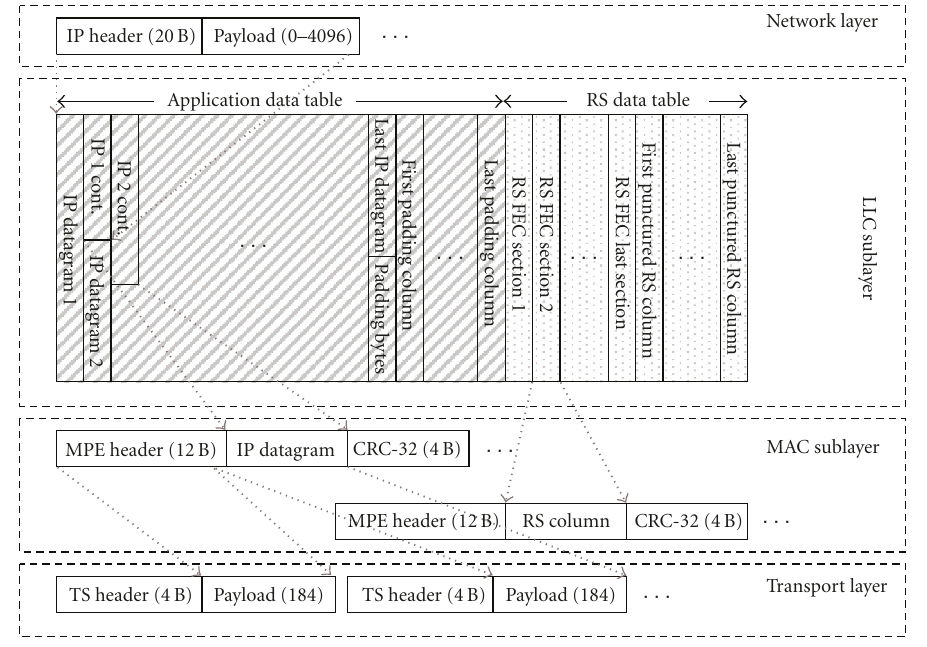
Figure 1: A subset of the protocol structure of DVB-H.